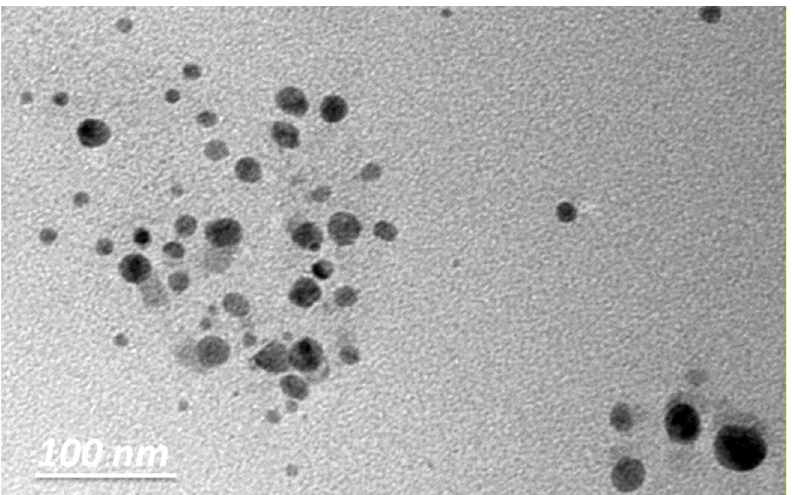
Fig. 5. TEM micrographs at scale bar 100 nm of green synthesized ZnO-NPs using ( A. niger ) extracellular